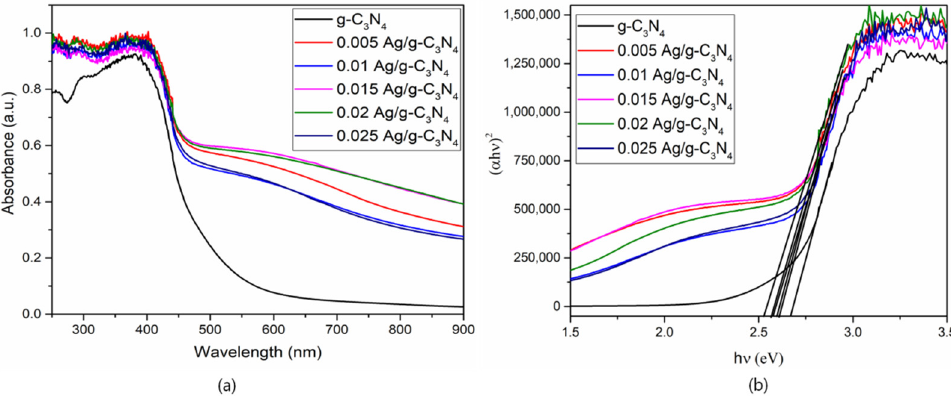
Figure 7. ( a ) UV-Vis-DRS properties of pristine and Ag/g-C 3 N 4 structures ( b ) bandgap values of O- Ag/g-C 3 N 4